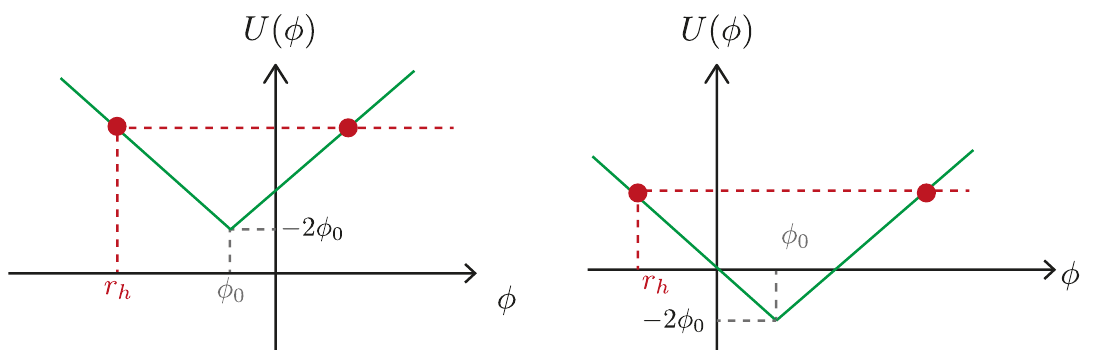
Figure 13. The γ -centaur potential for φ 0 < 0 (left) and φ 0 > 0 (right). The region where the slope is negative describes dS while the region where the slope is positive describes AdS and the crossing between the two regions happens at φ = φ 0 . There are at most two different values of r h corresponding to a given temperature T = U ( φ ( r h )) / 4 π indicated by red dots in this illustration. To have interpolating solutions we need r h < φ 0